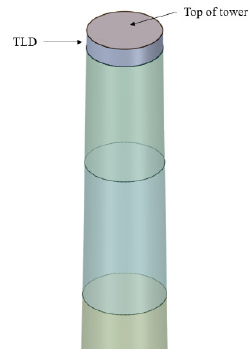
Figure 21. The conceptual sketch of the TLD on the top of the tower.